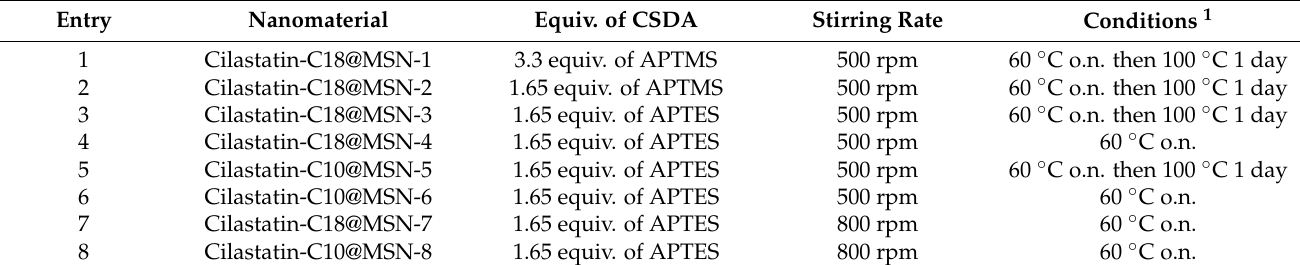
Table 1. Synthesis conditions of mesoporous silica nanoparticles with DSDAs of cilastatin-C10 and C18 (cilastatin-